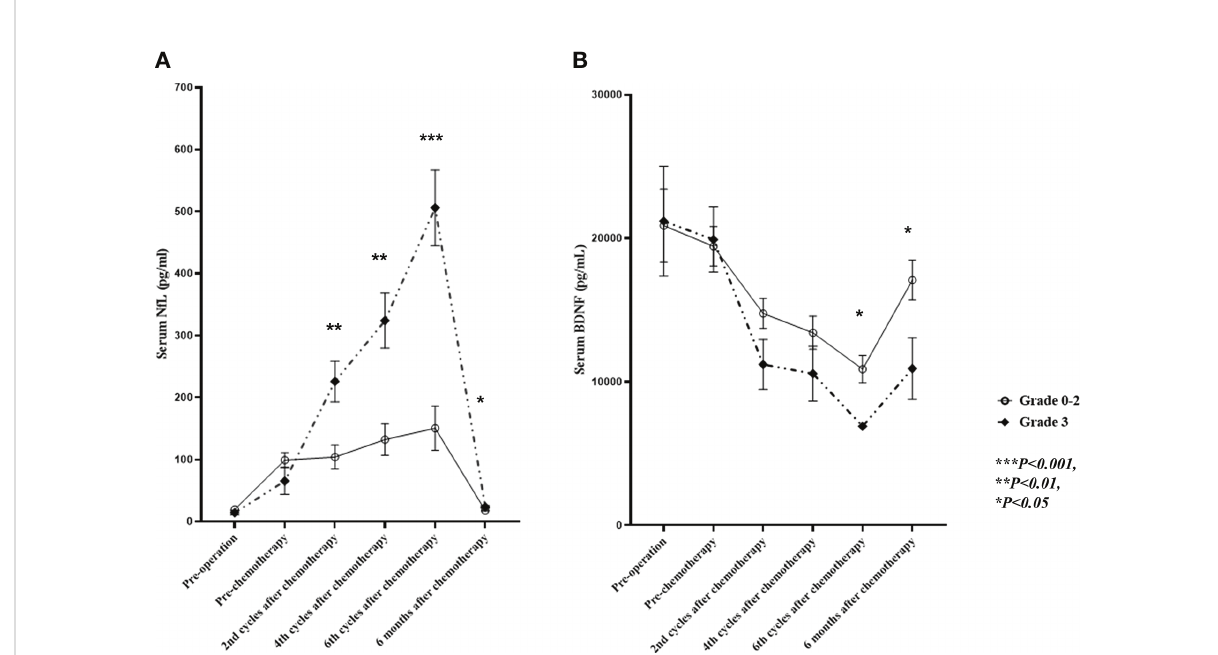
FIGURE 4 Comparison of sNfL and sBDNF levels in grade 3 vs. grade 0 – 2 PIPN patients. Shown are the (A) sNfL levels, and (B) sBDNF levels for patients with grade 3 and grade 0 – 2 PIPN during and 6 months after paclitaxel treatment. Data are presented as mean ± standard error, and the sNfL comparison has been adjusted for patient age. sNfL, serum neuro fi lament light chain; sBDNF, serum brain-derived neurotrophic factor; PIPN, paclitaxel-induced peripheral